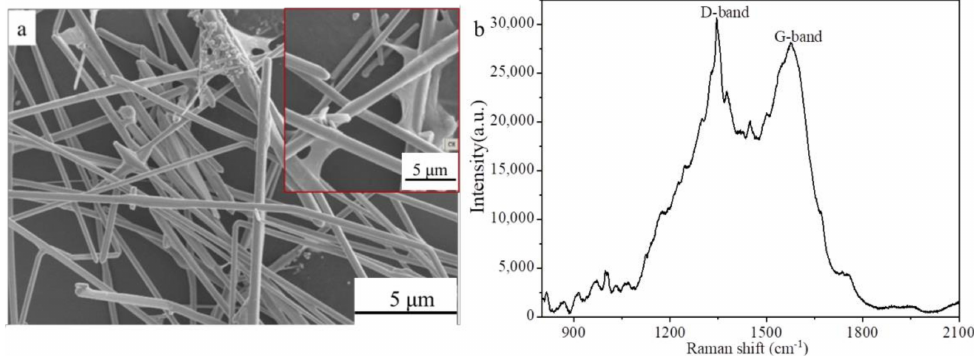
Figure 3. SEM image ( a ) and Raman spectrum ( b ) of the AgNWs-RGO composites. The inset is local